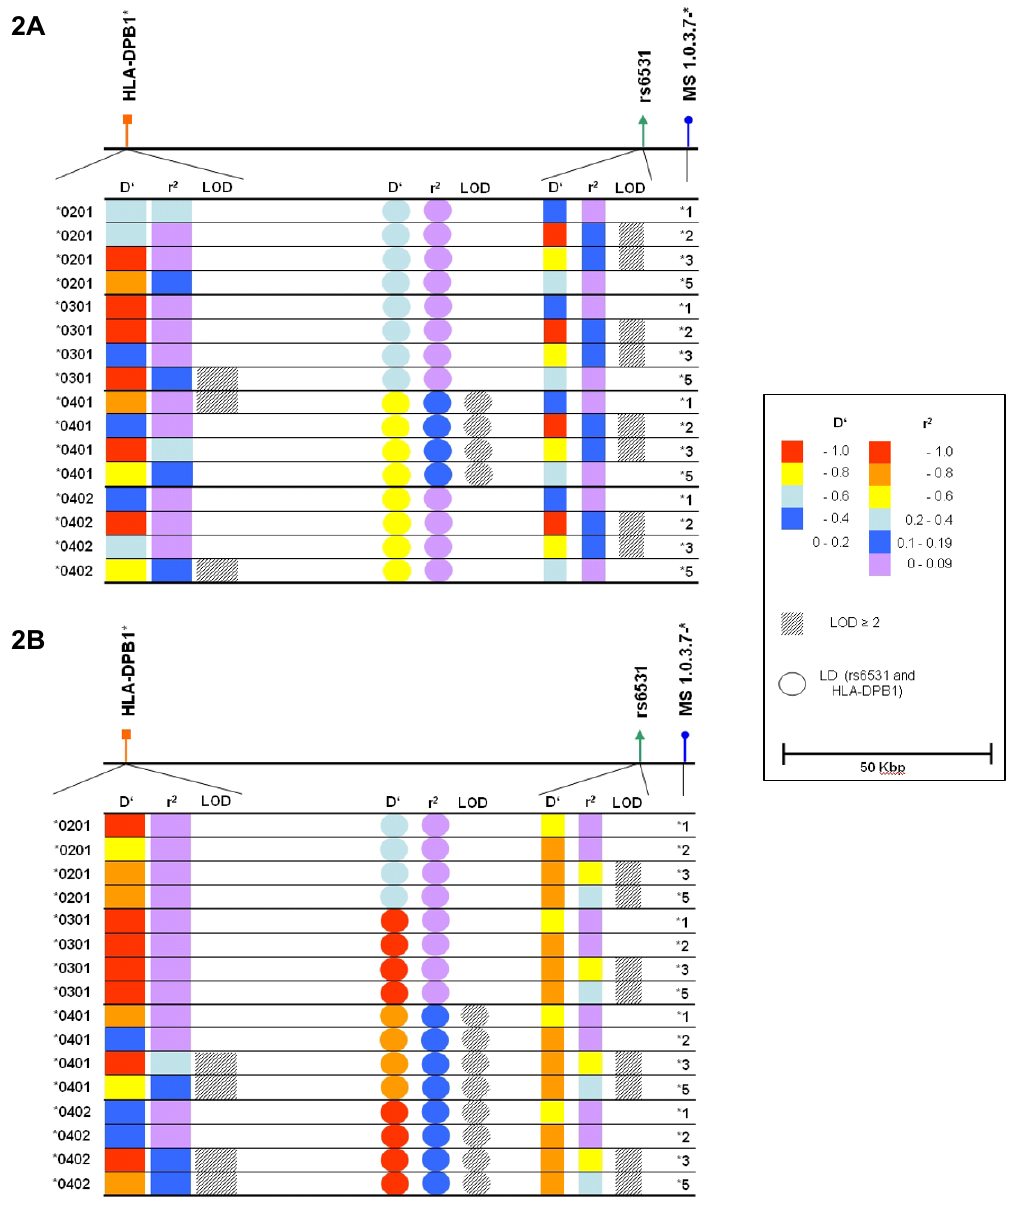
Figure 2 Graphical overview of LD analyses with frequent HLA-DPB1 alleles, the rs6531 polymorphism in the RXRB gene and alleles of the significantly WG-associated #1.0.3.7 microsatellite marker . Pair-wise LD evaluated by D' and r 2 between markers in the previously found WG associated chromosome 6 region for controls (2A) and patients (2B). Ver- tical lines with circle, triangle and square represent the relative localisation of each tested marker ( HLA-DPB1 , RXRB rs6531 and microsatellite marker #1.0.3.7, respectively). D' and r 2 values are indicated by colour coding. Logarithm of odds (LOD) values equal to or exceeding 2 are represented by dashed rectangles, circles or squares. Rectangles are related to LDs between the microsatellite #1.0.3.7 and HLA-DPB1 alleles. Circles represent LD values between HLA-DPB1 and the SNP. Squares show LDs between the microsatellite alleles and rs6531 SNP. The investigated alleles of the microsatellite markers are shown at the left hand side of the figure, whereas the different designations of the HLA-DPB1 alleles are depicted at the right hand side. MS: mic-